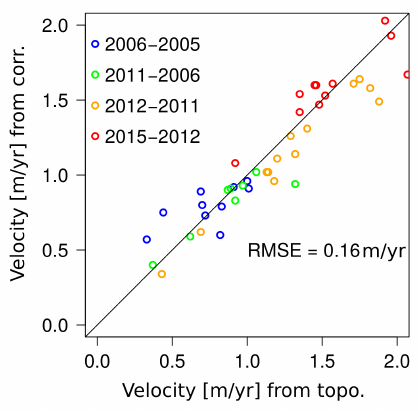
Figure 3. Surface velocity derived from image correlation (computed from the values of the 10 closest points around the actual position of the marked blocks) versus 3D surface velocity measured on marked blocks.